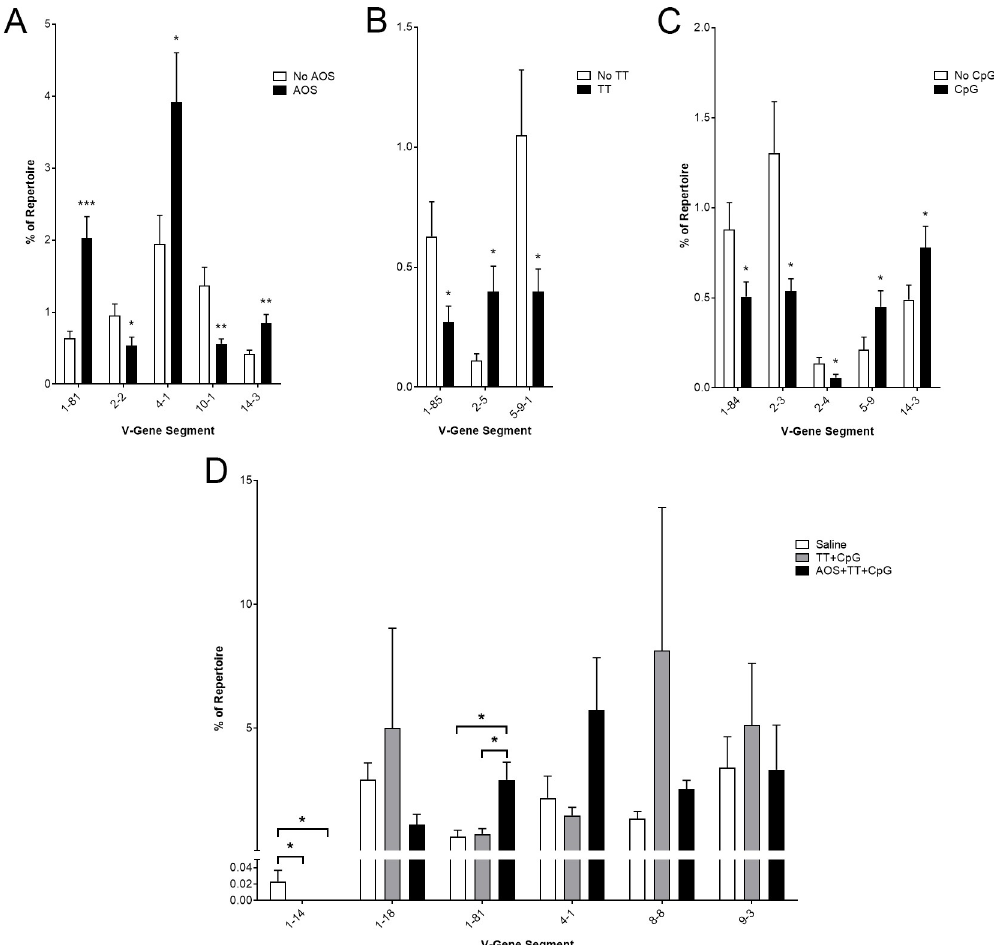
Fig 3. Impact of AOS, tetanus toxoid, and CpG on Splenic B cell Class switched VH-gene segment usage. Mice subjected to one or more treatment variables: Significantly different V-gene segment usage by main effect for AOS (A), TT (B), and CpG (C). (D) Significantly different V-gene segment usage and high frequency V-gene segment usage in saline, TT+CpG, and AOS+TT+CpG treatment groups. � = P < 0.05, �� = P < 0.01, ��� = P < 0.001.